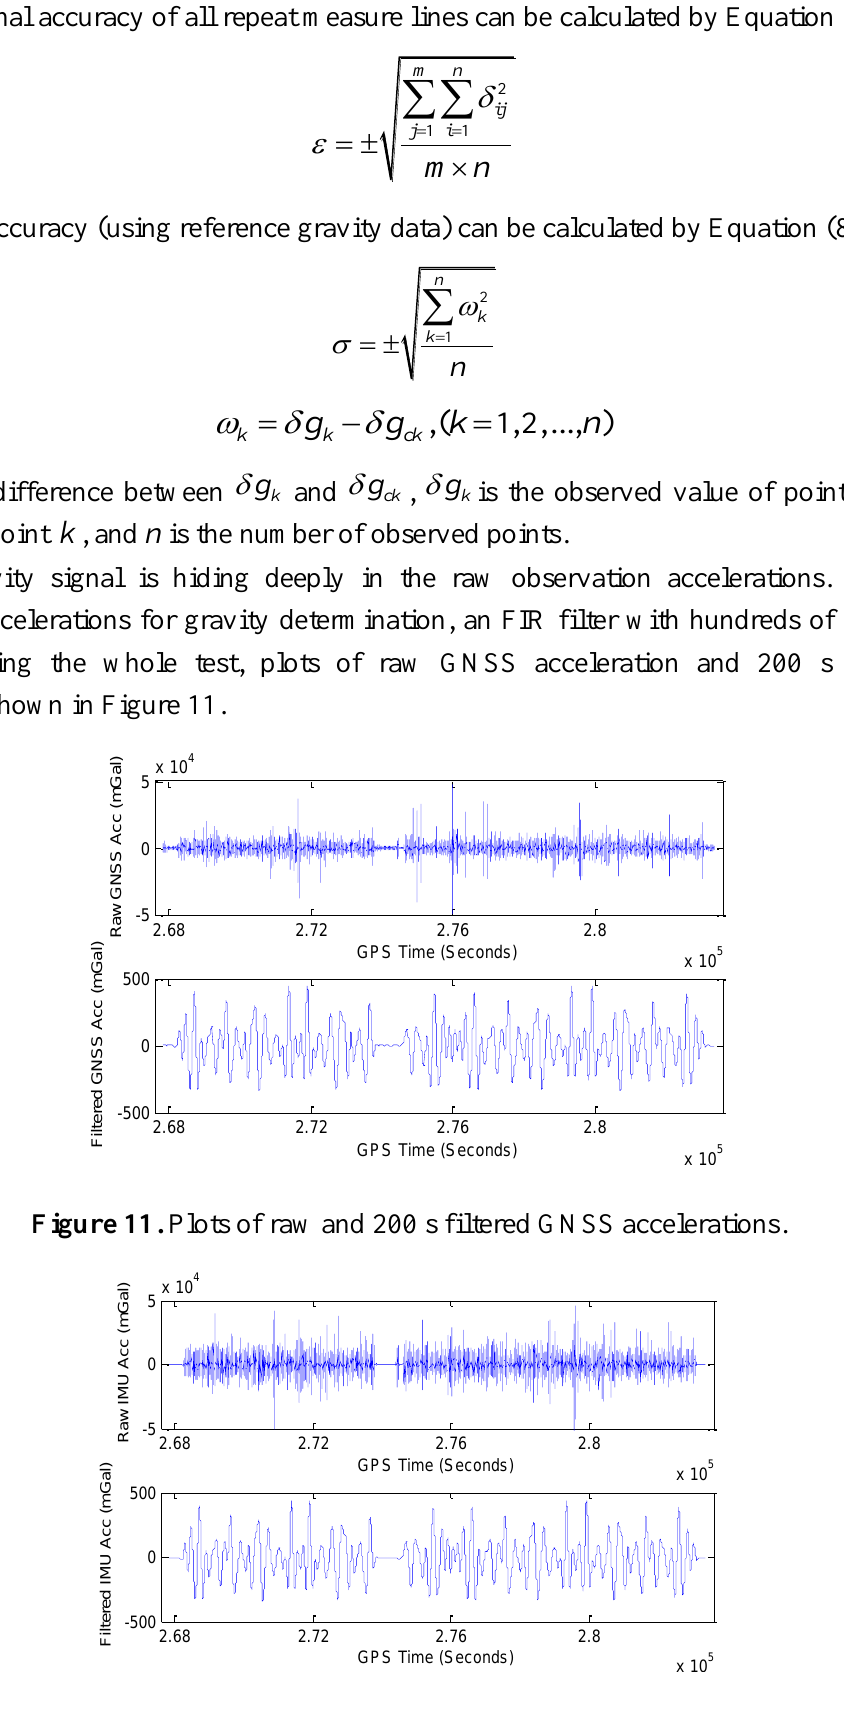
Figure 12. Plots of raw and 200 s filtered IMU